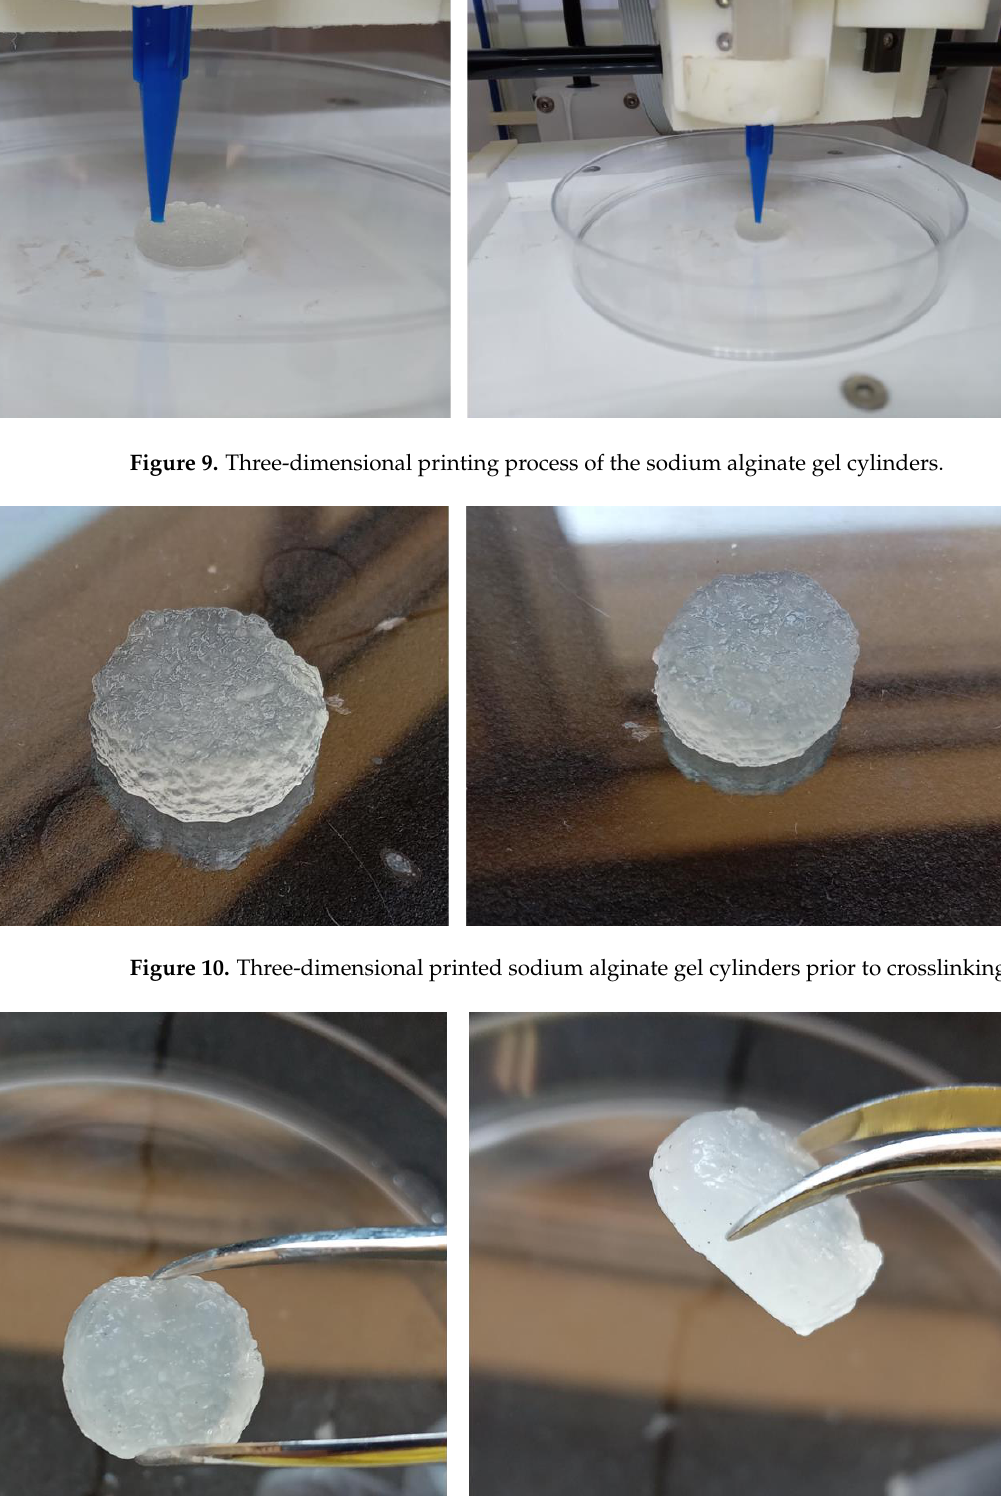
Figure 11. Free-standing 3D printed sodium alginate gel cylinders as the model mechanoresponsive system.